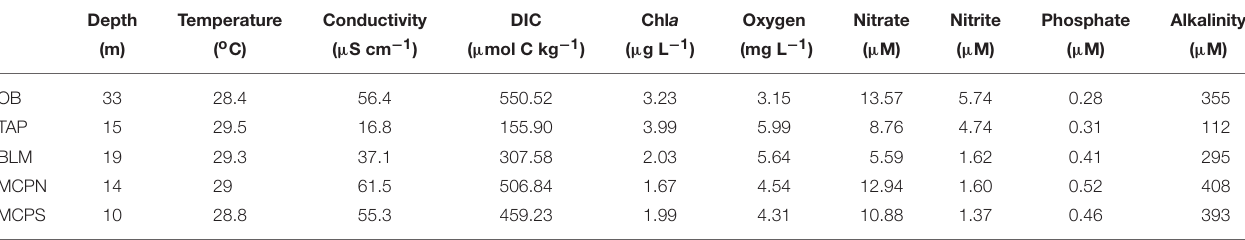
TABLE 2 | Environmental conditions at five Amazon River stations in May 2011.